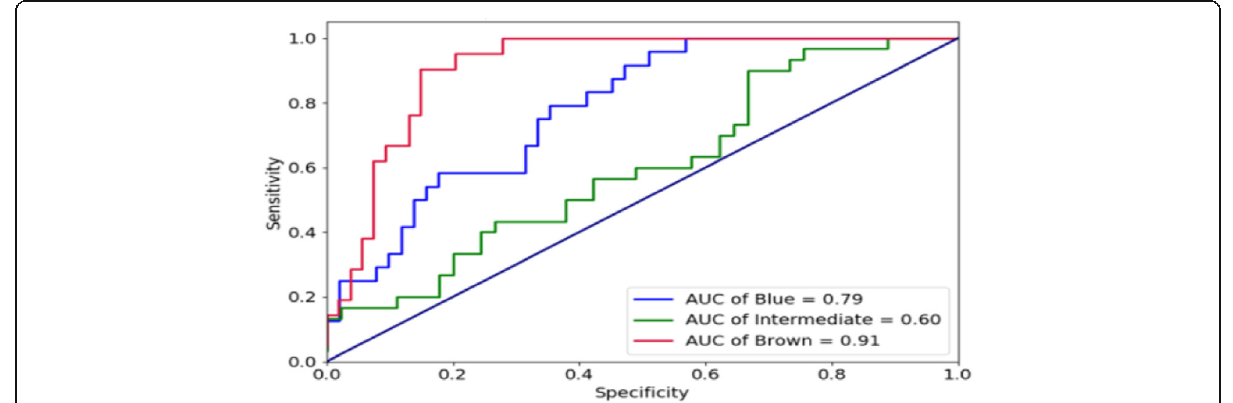
Table 2 Eye color prediction accuracy using 6 genetic markers in the Iraqi population Parameter Color Area under the receiver operating characteristic curve (AUC) Sensitivity (%) Specificity (%) Positive predictive value